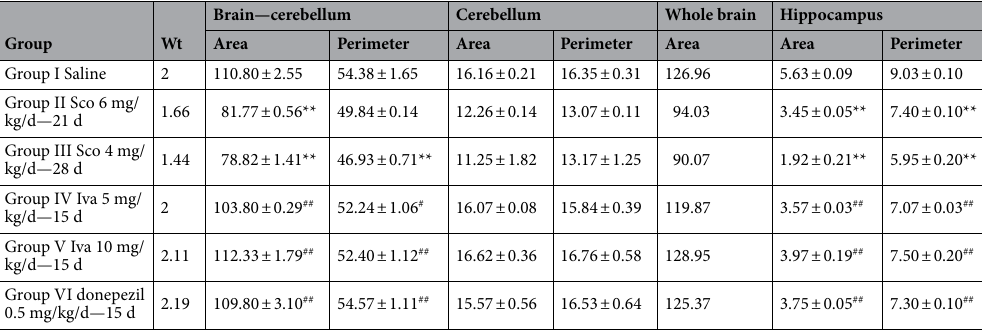
Table 2. Indicating the CSA of the brain excluding the cerebellum, its perimeter, CSA of the HC and its perimeter in different groups. Values are expressed as mean ± SEM of (8–10) rats. Analyzed using by one way ANOVA p < 0.01. **Highly significant (P > 0.01) difference from control group. # Significant (P > 0.05) and ## highly significant (P > 0.01) difference from dementia control group.